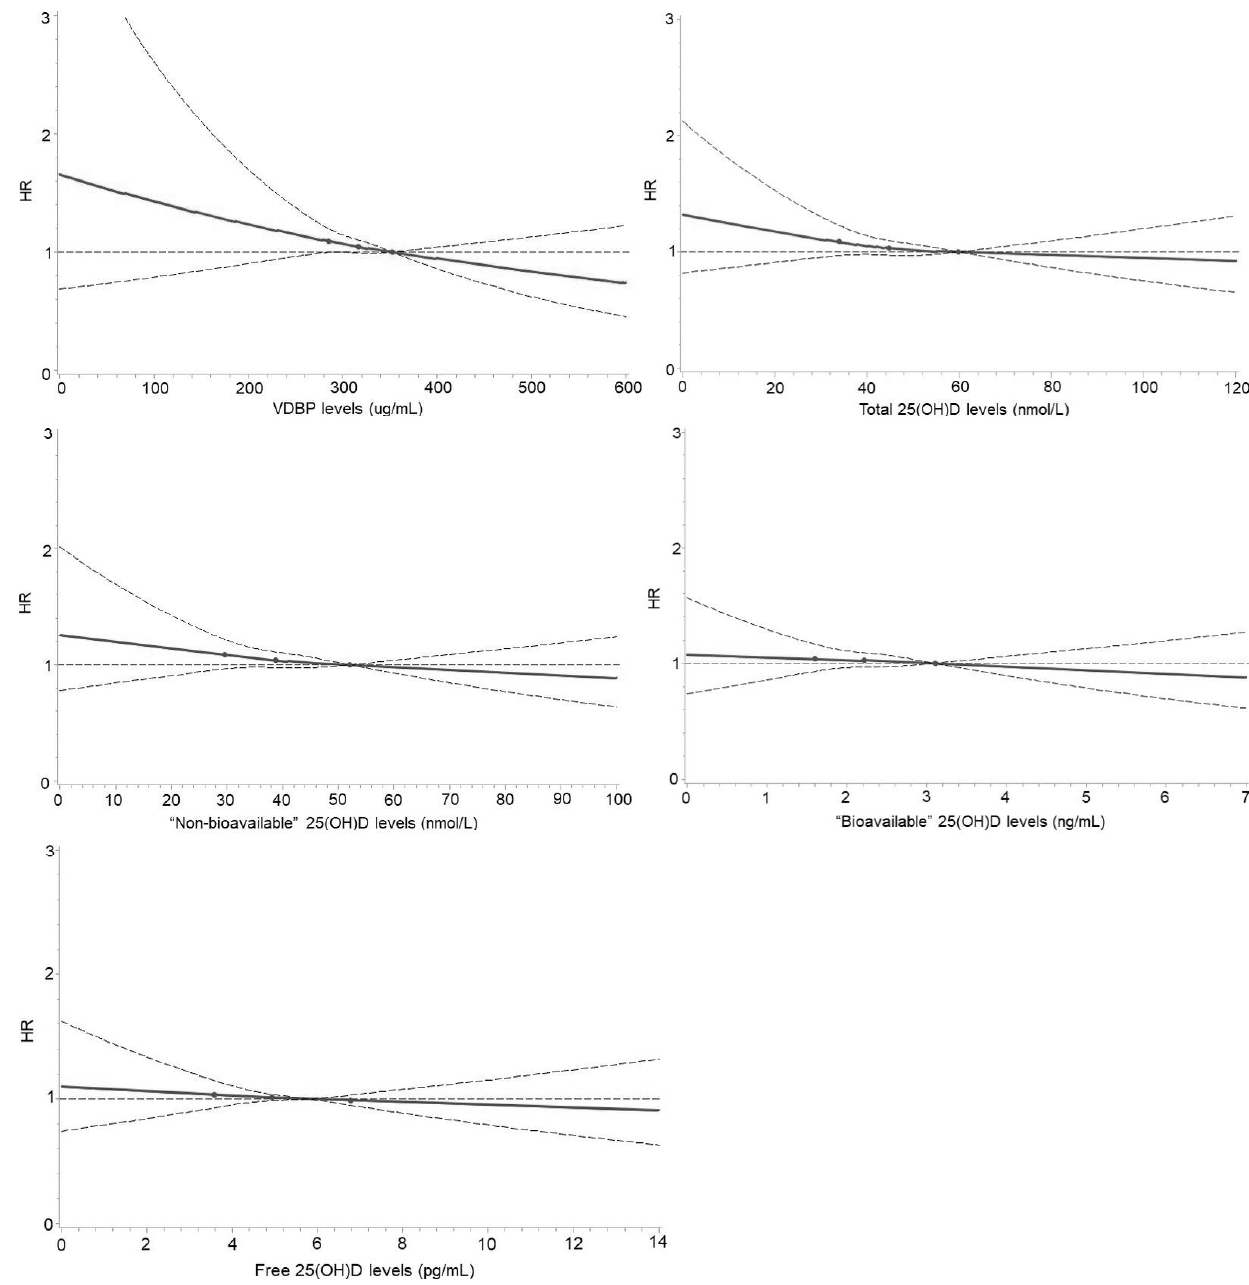
Figure 1. Dose–response curves for the associations of VDBP, total, “non-bioavailable”, “bioavailable”, and free 25(OH)D concentrations with risk of developing diabetes. Curves were derived using restricted cubic splines with three knots at 25, 50, and 75 (as the reference) percentiles of VDBP, total, “non-bioavailable”, “bioavailable”, and free 25(OH)D concentrations. Associations were multivariable-adjusted for age; sex; education; smoking and drinking status; vegetable, fruit, and fish consumption; regular intake of multivitamin supplements; body mass index; hemoglobin A1c; total cholesterol; high-density lipoprotein cholesterol; triglycerides; C-reactive protein; systolic blood pressure; estimated glomerular filtration rate; family history of diabetes; history of cardiovascular diseases and cancer; antihypertensive medication; lipid-lowering medication; and season of blood draw. There were 27 (0.6%) participants with VDBP > 600 µg/mL; 62 (1.3%) with total 25(OH)D > 120 nmol/L; 84 (1.7%) with “non-bioavailable” 25(OH)D > 100 nmol/L; 62 (1.3%) with “bioavailable” 25(OH)D > 7 ng/mL; and 105 (2.2%) with free 25(OH)D > 14 pg/mL.